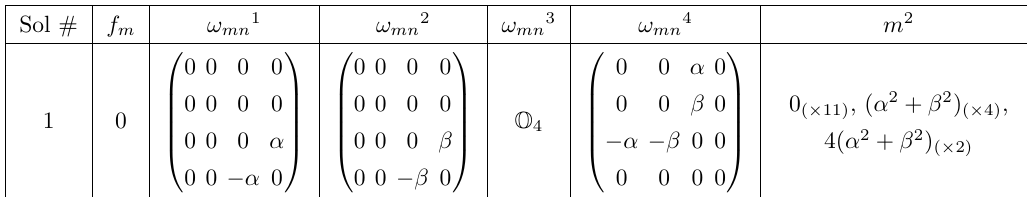
Table 24 . Non-vanishing QC (3.6) and their higher-dimensional origin for the (cid:13)ux compacti(cid:12)cation of type IIB with O9/D9 given in table 22, where Jacobi refers to the condition (2.10). A description of the QC as restrictions for the existence of additional local sources is given.